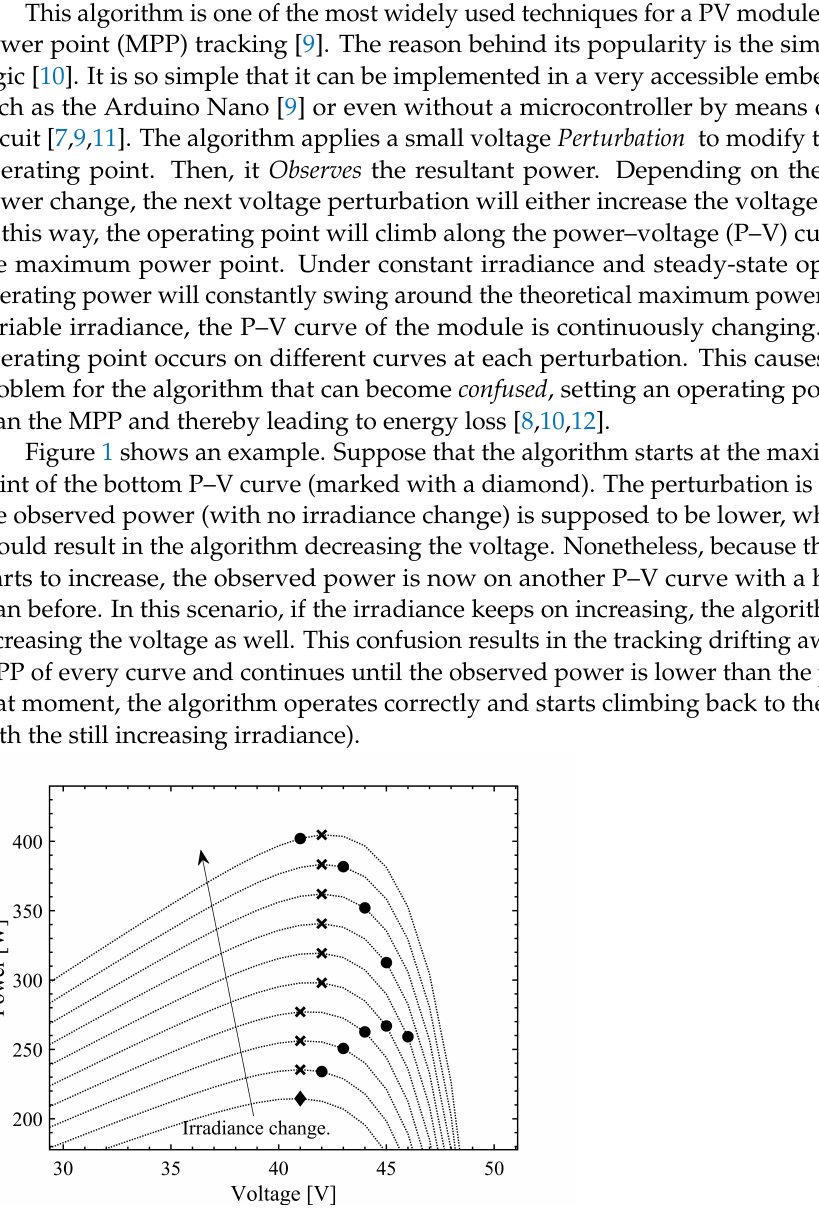
Figure 1. Example of the P&O confusion when the irradiance increases. The circles indicate the tracking points. The ‘x’ denotes the maximum power point at each P–V curve, and the diamond marks the starting